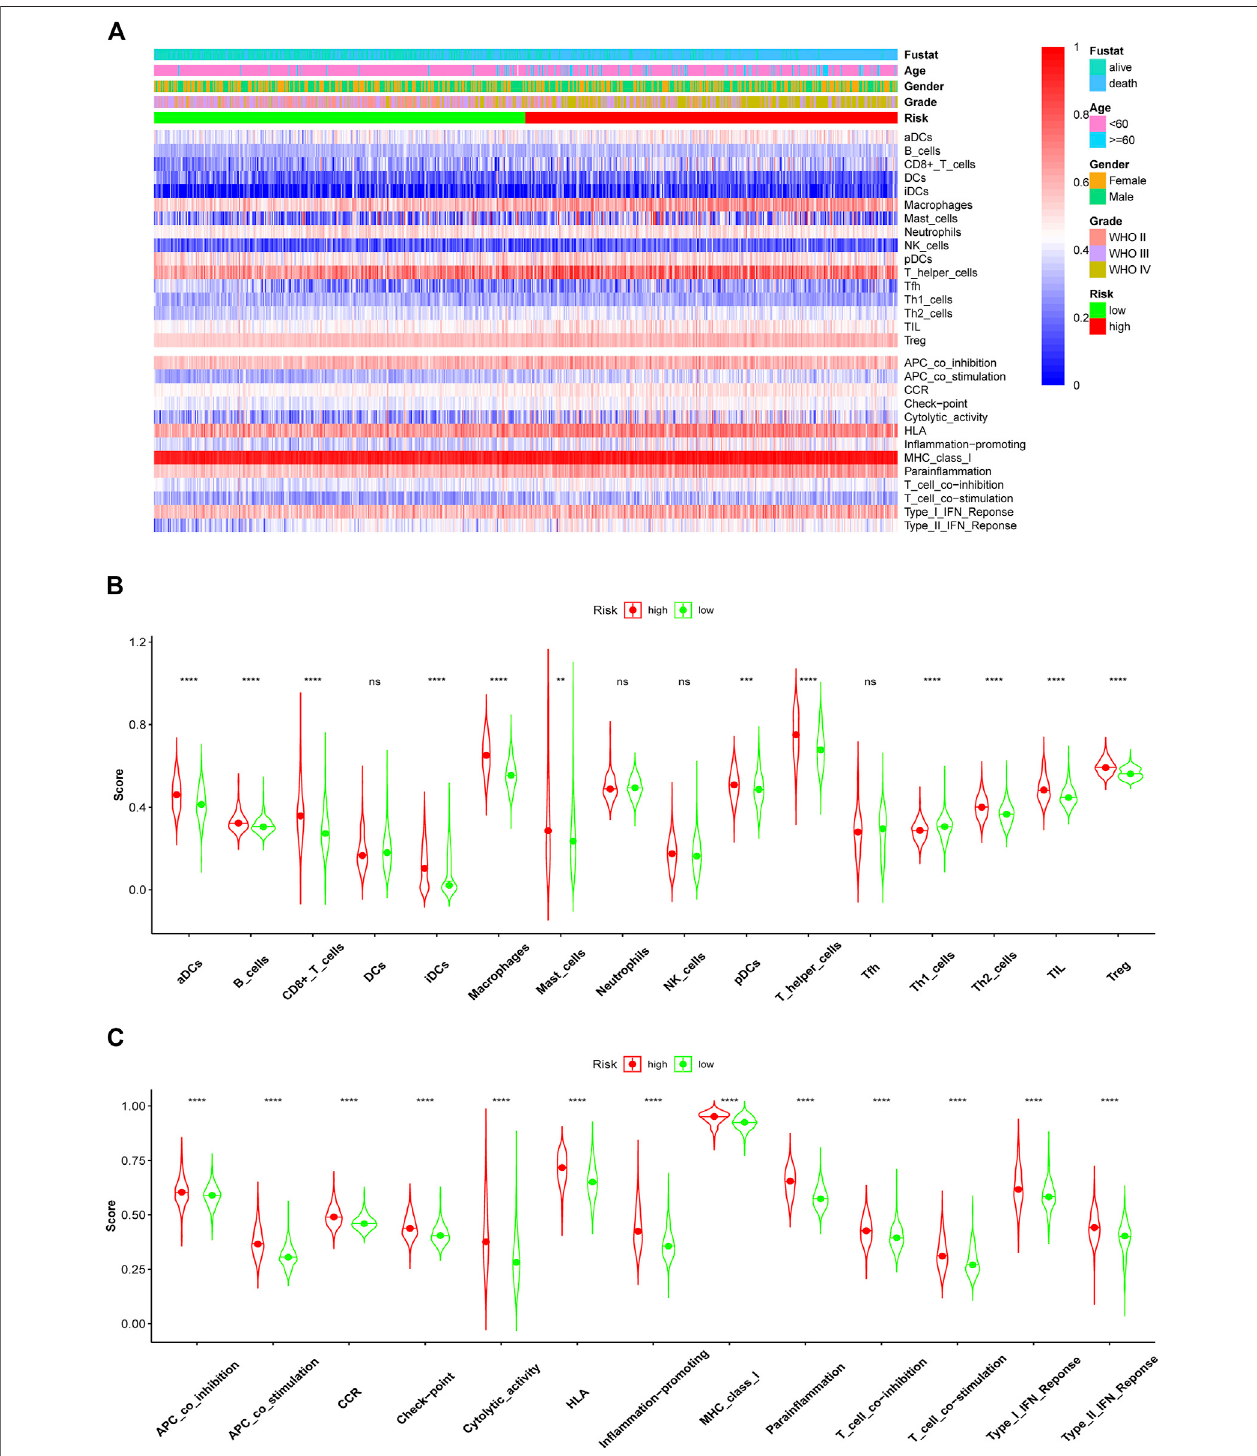
FIGURE 9 | Comparison of immune cell in fi ltration and functions elevated by ssGSEA between the high- and low-risk groups in the training CGGA693 cohort. (A) Heatmap of ssGSEA scores of immune cells and functions. The ssGSEA scores of 16 immune cells (B) and 13 immune functions (C) between the high- and low-risk groups of glioma patients in violin plots.